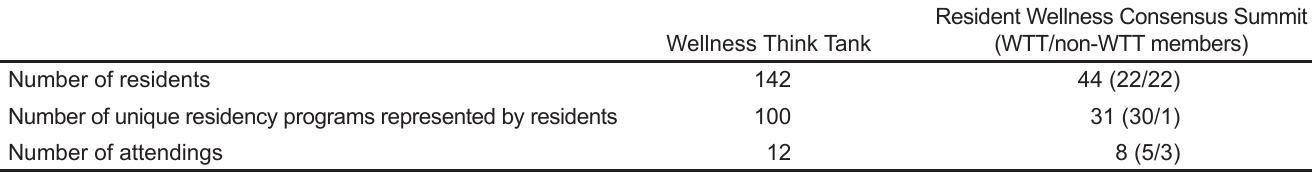
Table. Demographic data on members of the Wellness Think Tank (WTT) and the Resident Wellness Consensus